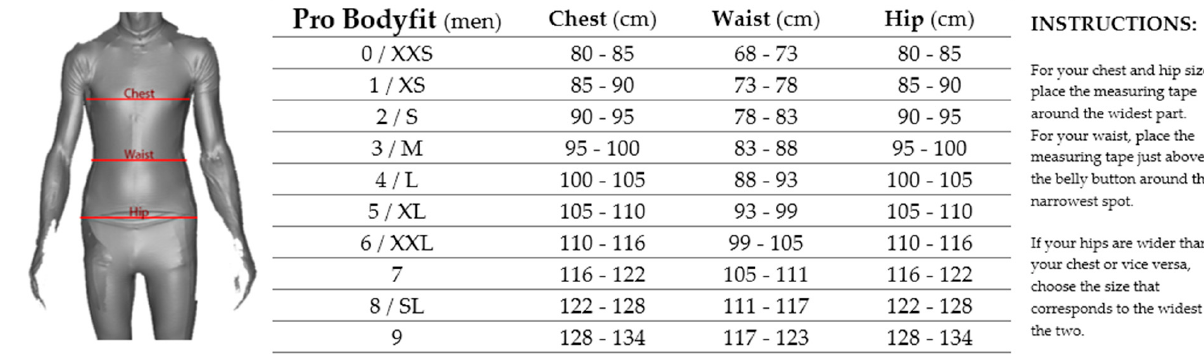
Figure 2. Custom made research garments in the standard confection sizes. The custom print con- sists of a 1 × 1 cm grid of lines that aid in 3D scanning and measuring of stretch. 2.3.2. Styku 3D Scanner The Styku scanner is a commercially available scanning system that is mainly ori- ented on the fitness, health, and wellness sectors [30]. It rotates the subject on a turntable and scans using a Microsoft Kinect V2 scanner, as seen in [31,32]. Its proprietary software requires data input such as body weight and stature, and then scans one full rotation. Data are processed by the proprietary software, and provides a reliable [28] an easy-to-under- stand overview of common measurements on the body, as well as volume and outline traces [30]. This setup is included as it could be a commercial cost-effective method for receiving relatively accurate measurements with a simplified interface and mode of oper- ation [31,32]. Thus, it can deliver fast (around two minutes) and cheap measurements in a retail or professional environment. However, it has the downside of requiring the subject to be almost naked (underwear) or wearing skin-tight garment (i.e., being almost as time